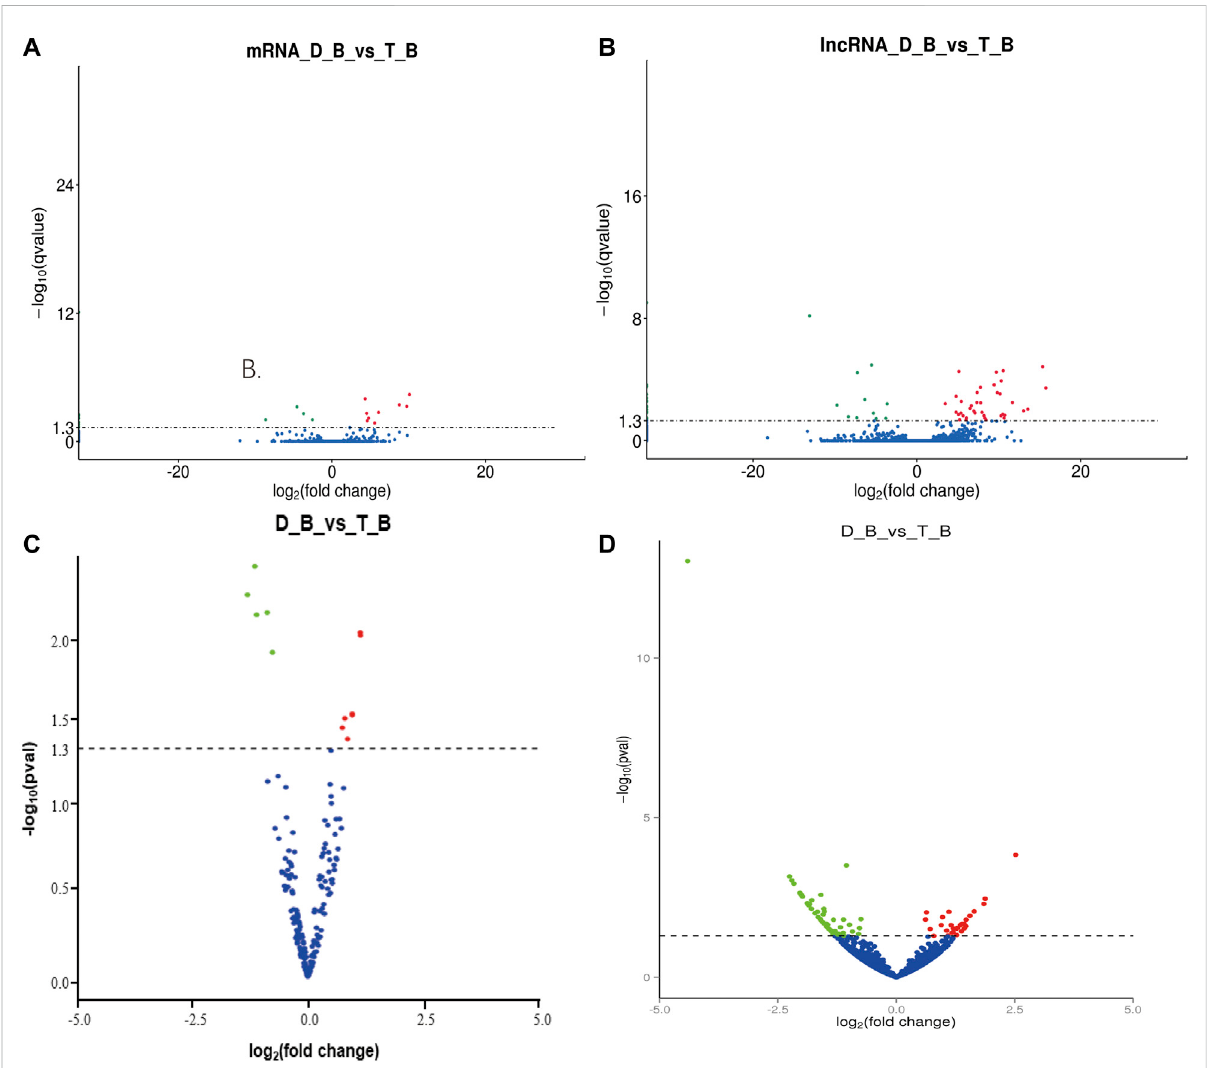
DifferentiallyexpressedmRNAsandnon-codingRNAsinTansheepandDorpersheep. (A) Expression pro fi lesofmRNAinbicepsfemorisofTan sheep and Dorper sheep. (B) Expression pro fi les of IncRNA in biceps femoris of Tan sheep and Dorper sheep. (C) Expression pro fi les of miRNA in biceps femoris of Tan sheep and Dorper sheep. (D) Expression pro fi les of circRNA in biceps femoris of Tan sheep and Dorper sheep. In the volcano plots, green points represent downregulated RNAs, while red points represent upregulated RNAS. “ D_B ” is the biceps femoris group of the Dorper sheep. “ T_B ” is the biceps femoris group of the Tan